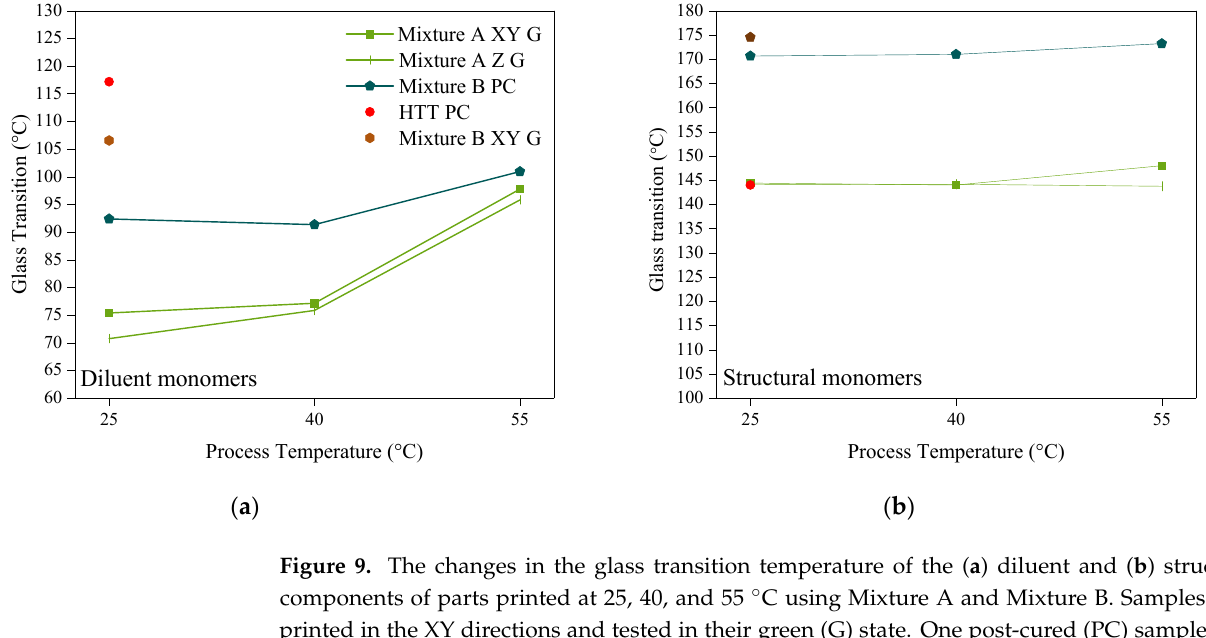
Figure 9. The changes in the glass transition temperature of the ( a ) diluent and ( b ) structural components of parts printed at 25, 40, and 55 °C using Mixture A and Mixture B. Samples were printed in the XY directions and tested in their green (G) state. One post-cured (PC) sample from each mixture was tested for reference. Table 5. The T g associated with the structural and diluent components of the two photoresins at different process temperatures and in their post-cured state.